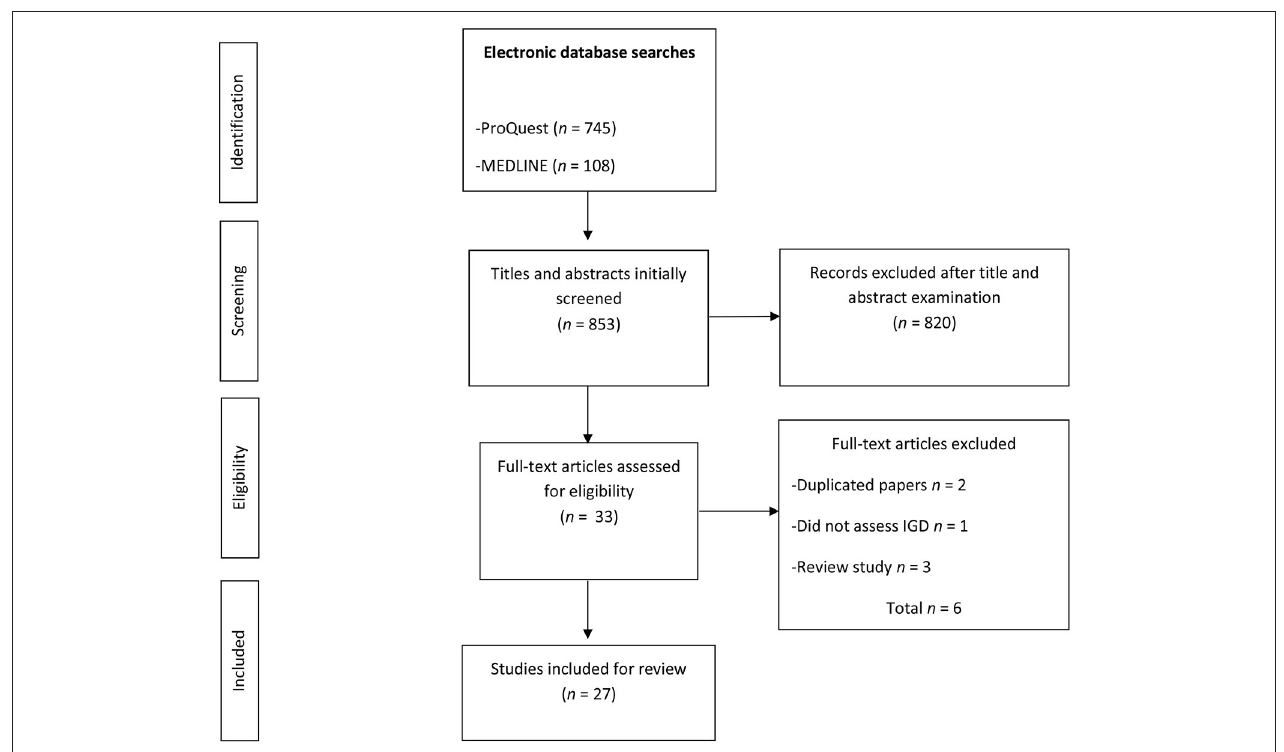
FIGURE 1 | Flow diagram of the study selection